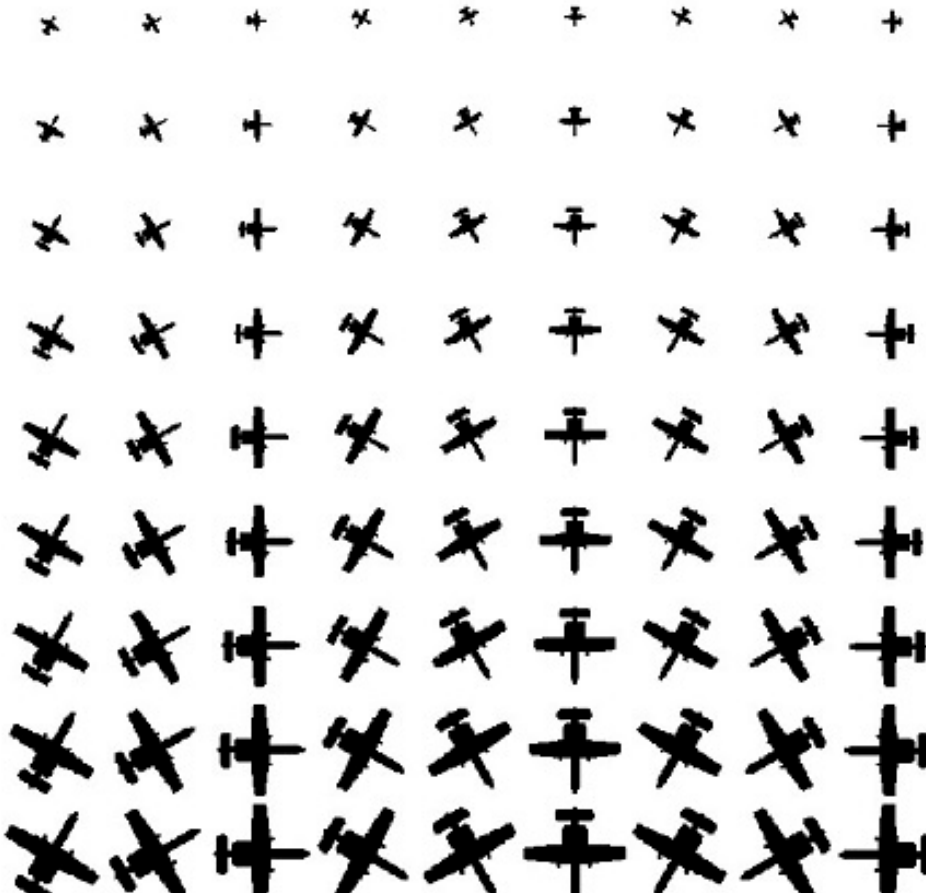
Figure 3. The noisy images with SNR = 20, 15, 10, 5, 4, 3, 2, 1, and 0.5, respectively.